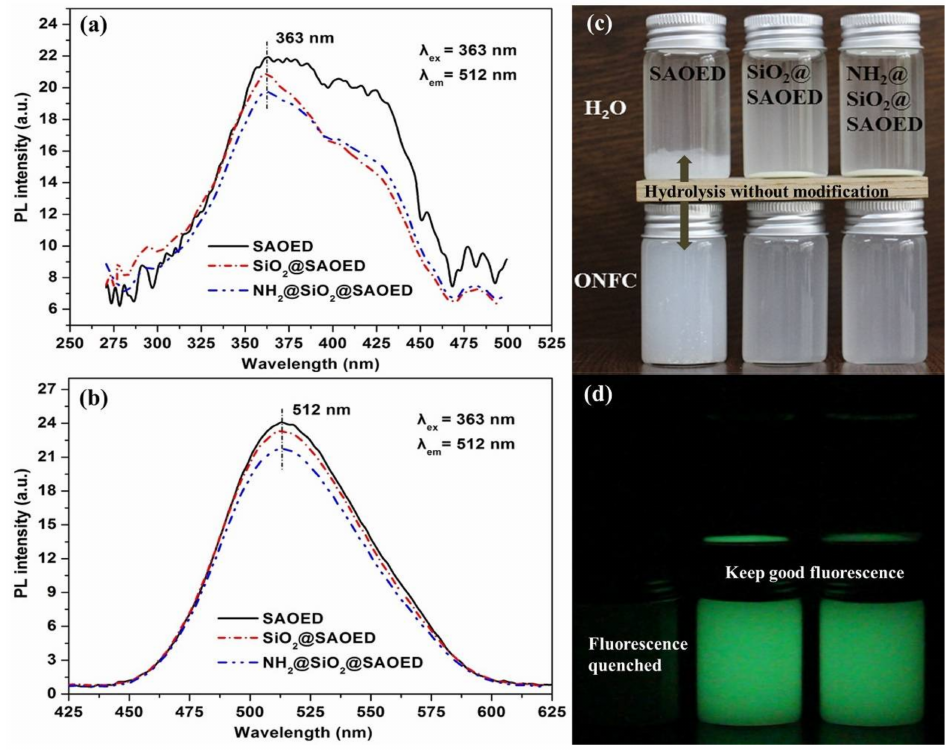
Figure 4. Photoluminescent (PL) spectra of SAOED phosphors and different suspensions in water and ONFC: ( a ) excitation and ( b ) emission spectra of phosphors before and after surface coated modification. Excitation wavelength λ ex = 363 nm was considered for emission spectra measurements; Digital photographs of the phosphors dispersed into distilled water (first row) and ONFC suspension (second row) for 24 h ( c ) in daylight and ( d ) in